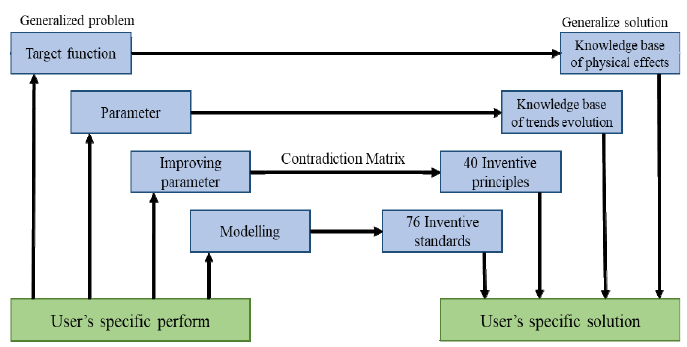
Figure 1. Contributions of TRIZ (Revised from